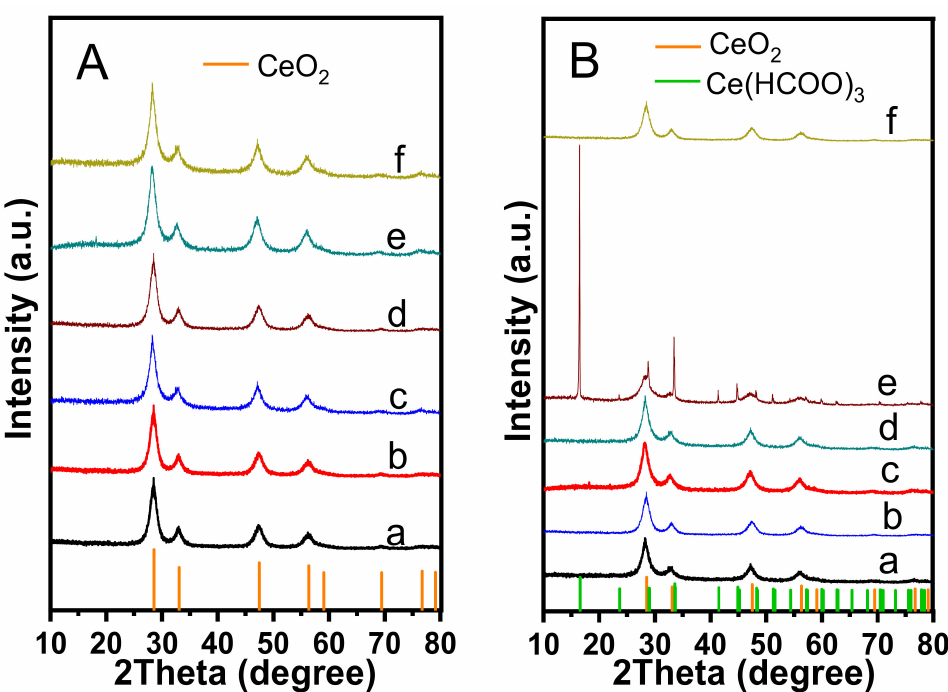
Figure 5. ( A ) XRD patterns of (a) CeO 2 -NS 2 h before calcination; (b) CeO 2 -NS 2 h; (c) CeO 2 -NS 4 h before calcination; (d) CeO 2 -NS 4 h; (e) CeO 2 -NS before calcination and (f) CeO 2 -NS; ( B ) XRD patterns of (a) CeO 2 -NS-NA 2 h before calcination; (b) CeO 2 -NS-NA 2 h; (c) CeO 2 -NS-NA 4 h before calcination; (d) CeO 2 -NS-NA 4 h; (e) CeO 2 -NS-NA before calcination, and (f) CeO 2